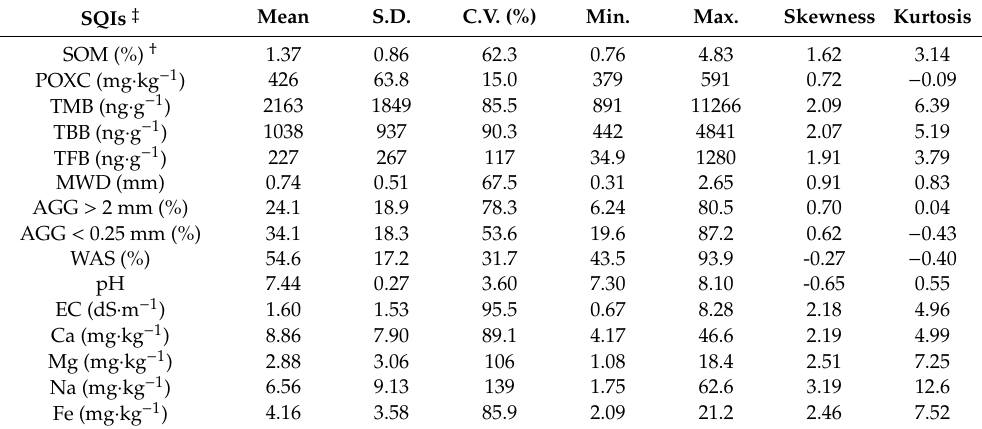
Table 3. Descriptive statistics for laboratory-measured soil quality indicators (SQIs) using a dataset from all locations in New Mexico (n =